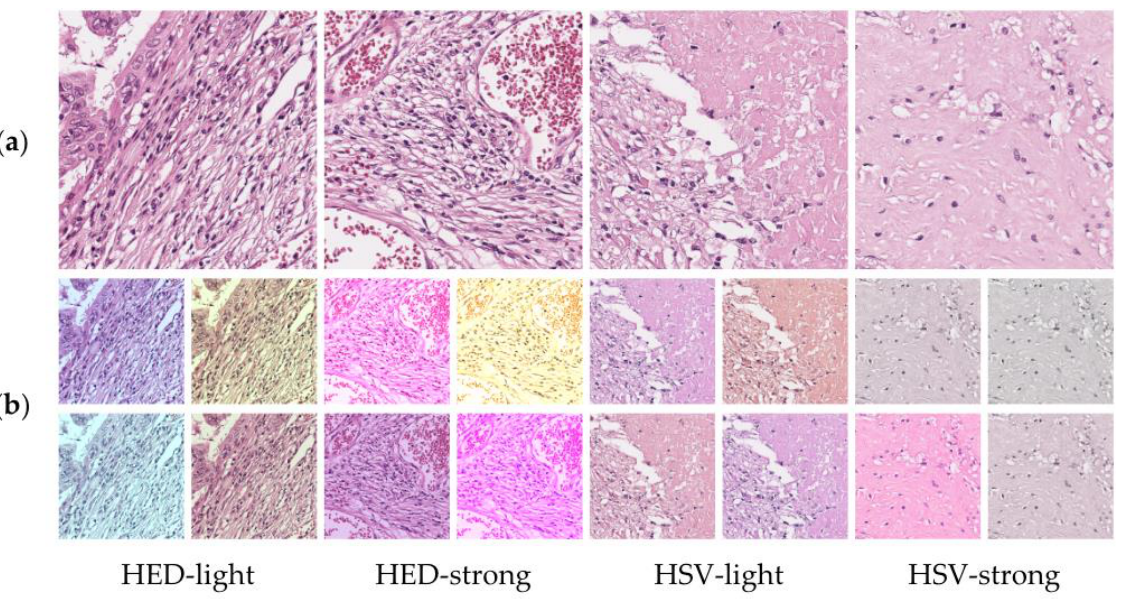
Figure 4. Examples of HED and HSV color transformations: ( a ) original patches and ( b ) color-transformed patches.